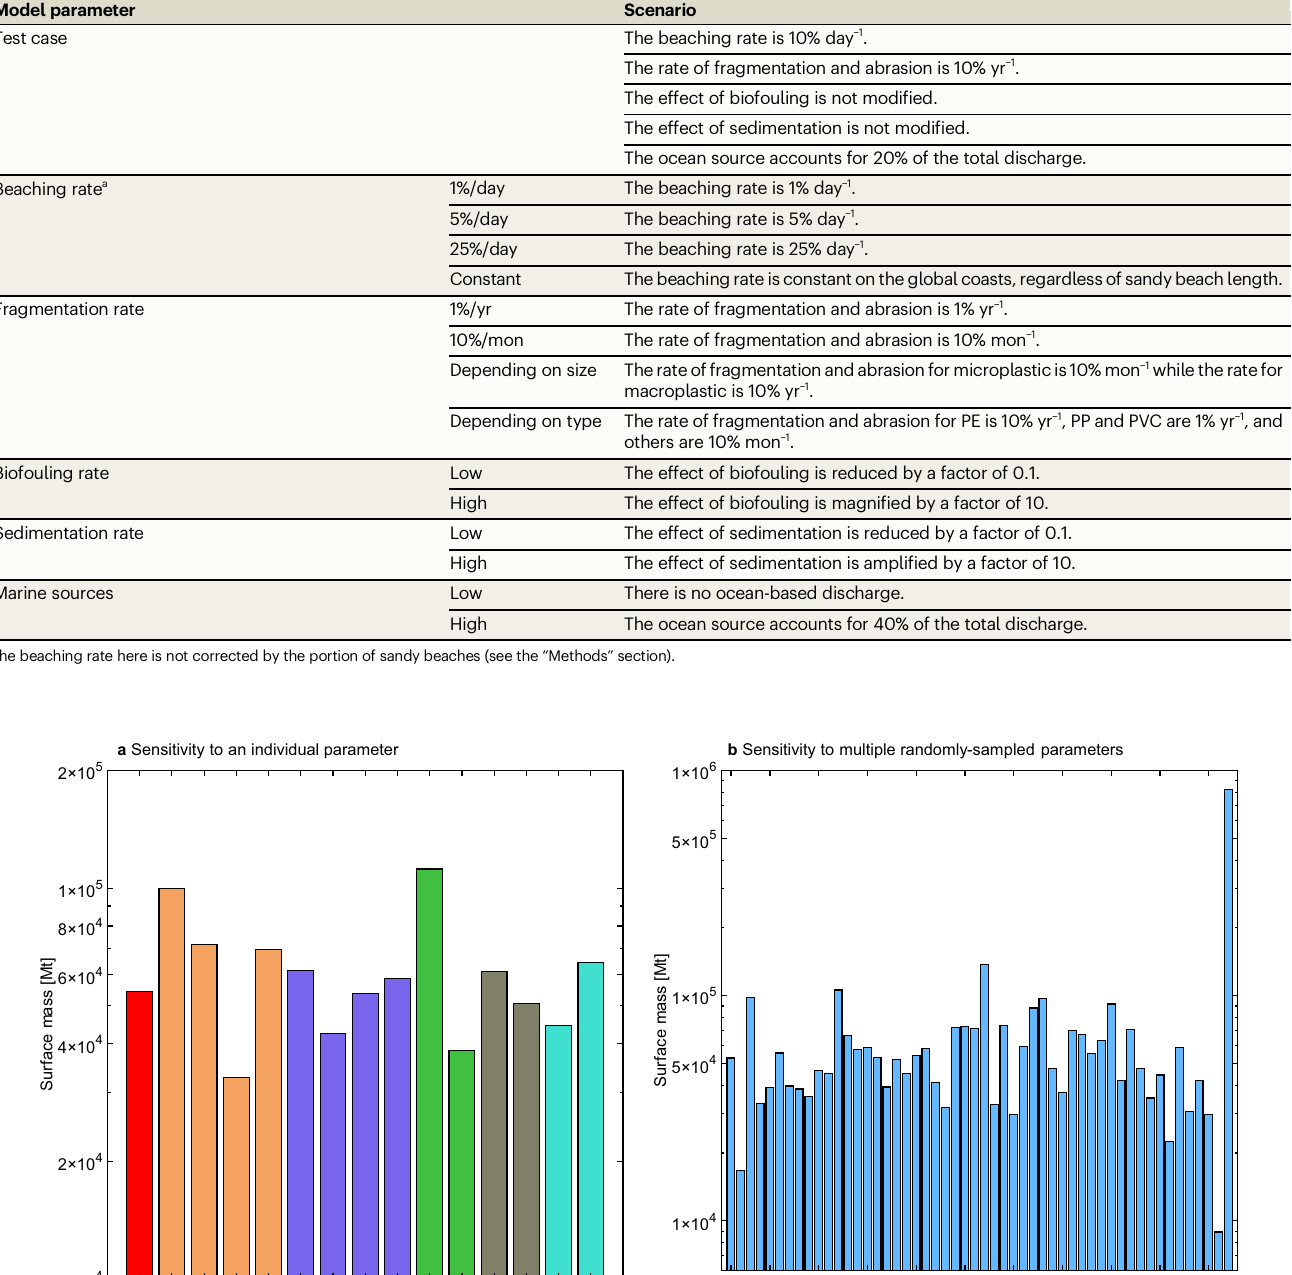
Table 1 | Model parameter sensitivity analyzed in this study Model parameter Scenario Test case